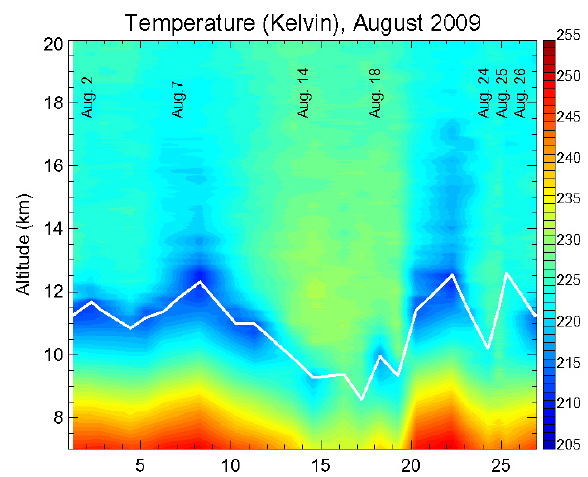
Fig. 9. Evolution of the temperature and thermal tropopause height (white line) from ozone-sonde observations in August 2009. The dates of the STAC flights are indicated in